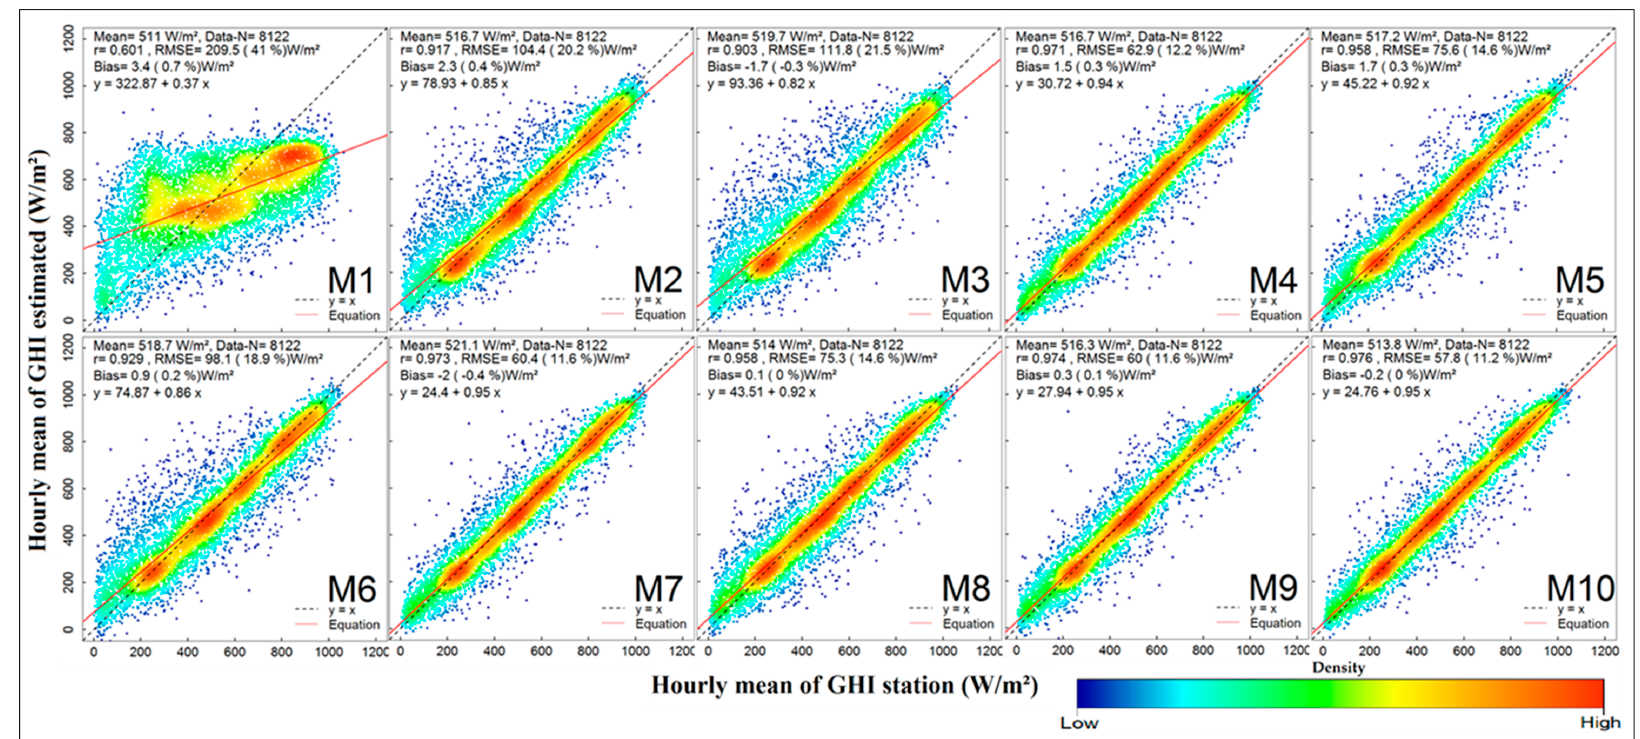
Figure 6. Scatterplots of hourly GHI ground measurements and ANN model estimated from M1–M10 at test data for overall results at tower stations.